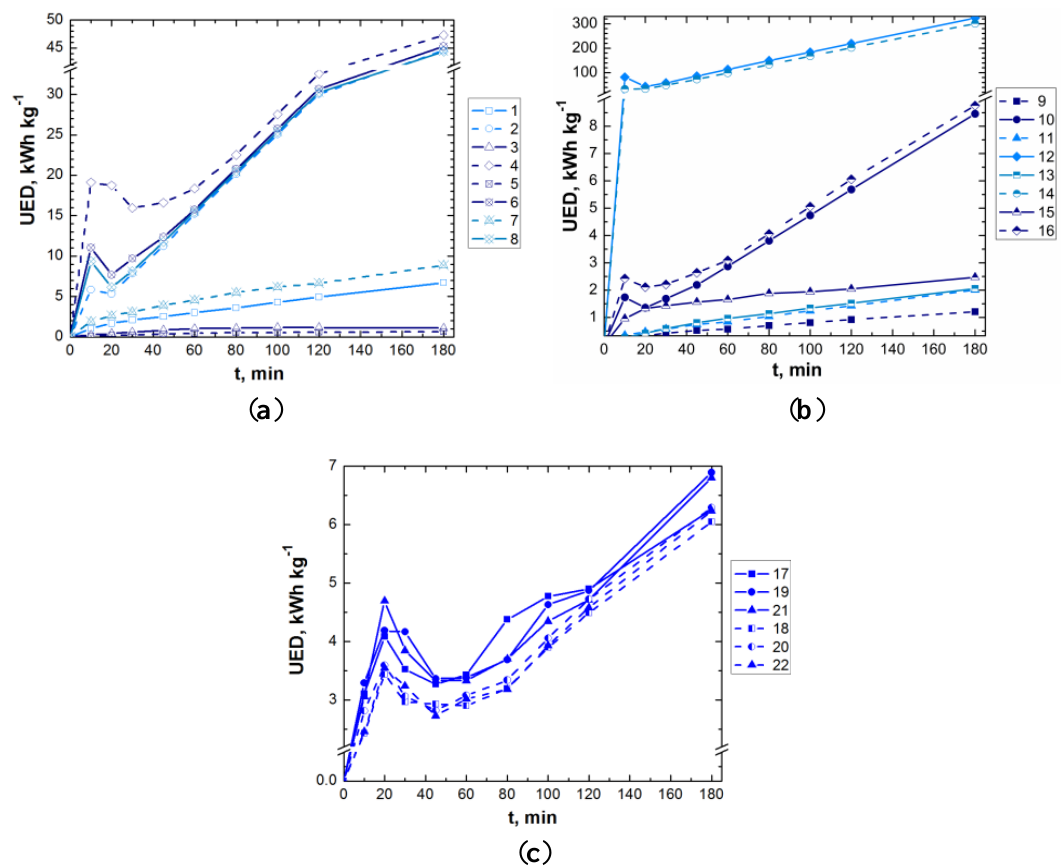
Figure 5. Evolution of unit energy demand ( UED) during EC /CAG coupling (experimental conditions are depicted in Table 3; solid line— DC , dashed line— APC ; light blue, blue and navy blue lines—low, center and high values of dye concentration).